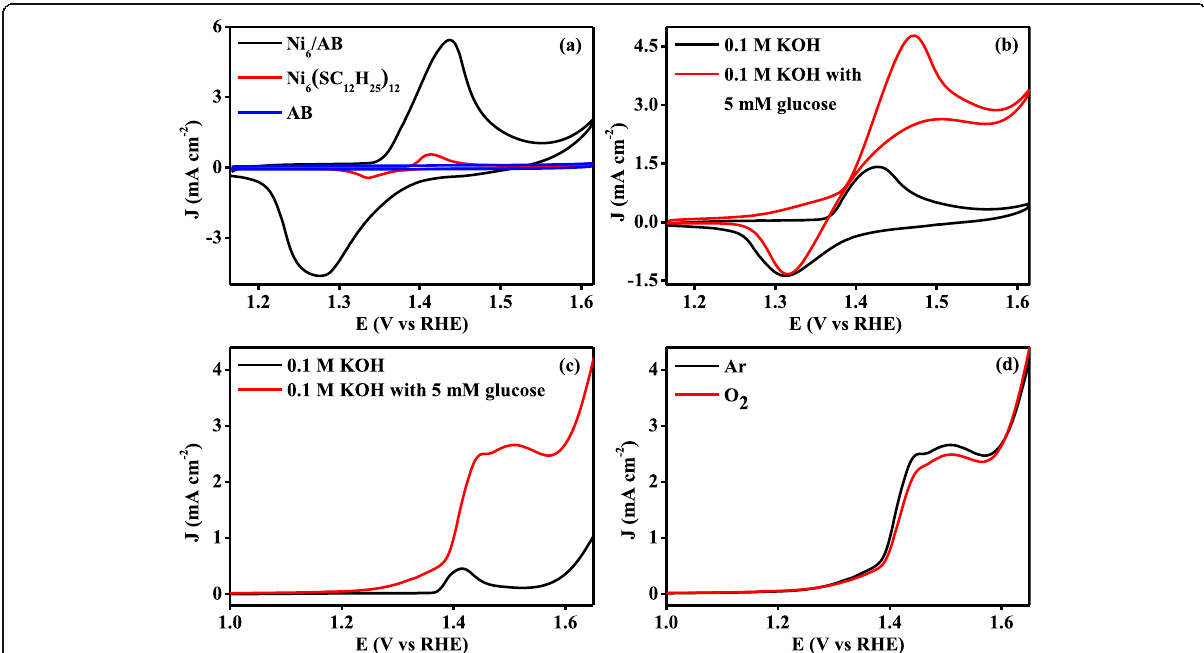
Fig. 3 a Cyclic voltammtric curves of the Ni 6 /AB composites, Ni 6 (SC 12 H 25 ) 12 , and AB in 0.1 KOH with the scan rate of 50 mV/s. b Cyclic voltametric curves of the Ni 6 /AB composites in 0.1 M KOH without or with the presence of 5 mM glucose with the scan rate of 50 mV/s. c Linear sweep voltametric curves of the Ni 6 /AB composites in 0.1 M KOH without or with the presence of 5 mM glucose with the scan rate of 10 mV/s. d Linear sweep voltametric curves of the Ni